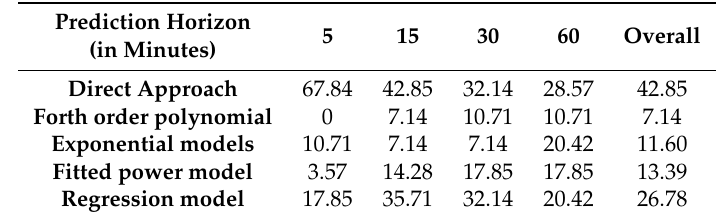
Table 6. Percentages of best performance of direct and indirect prediction approaches for different prediction